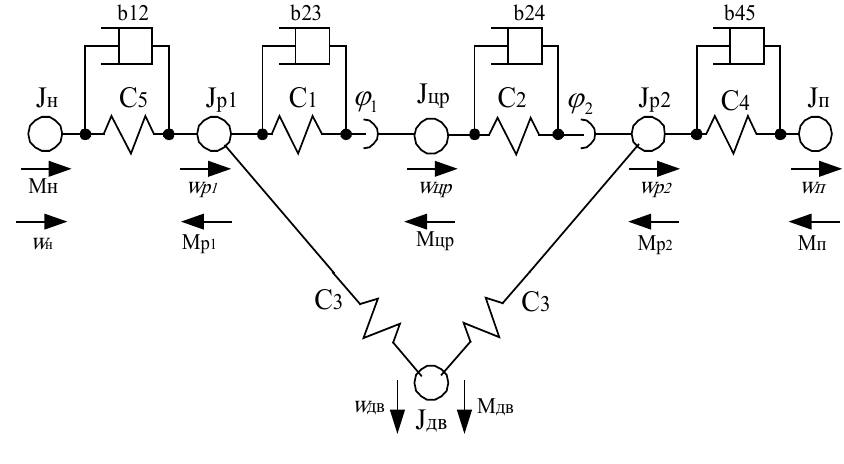
Figure 3. The design diagram of the filled